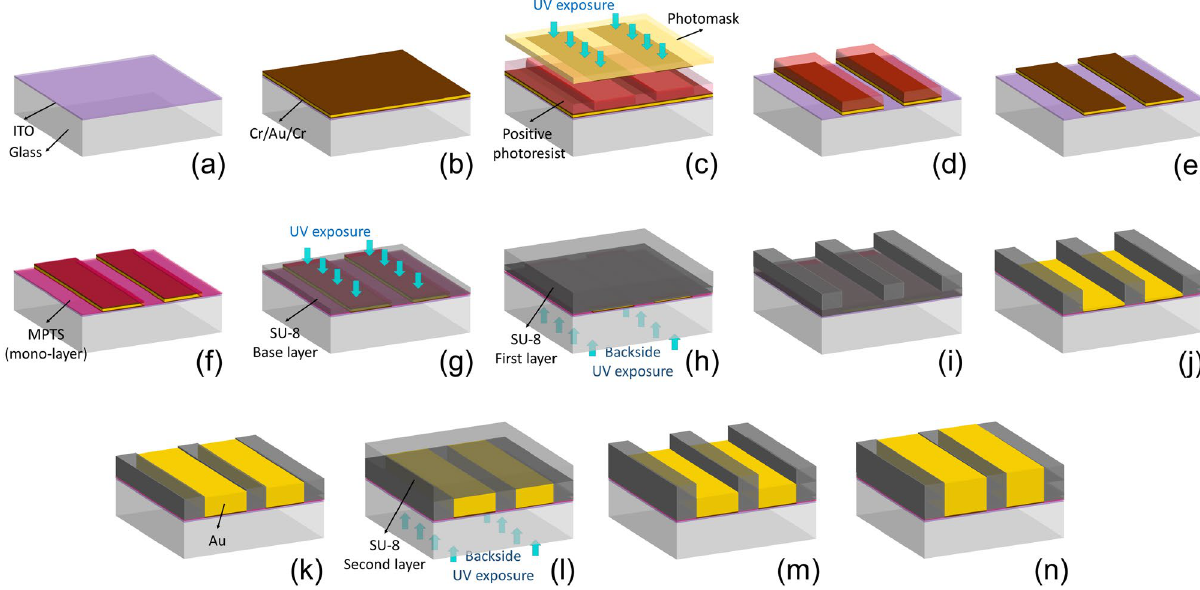
Figure 1. Process flow for fabricating self-aligned multi-layer high aspect ratio gratings. This graph illustrates the fabrication steps for two layers, where repeating steps (l) to (n) results in a multi-layer structure: ( a ) cleaning the ITO-on-glass substrate, ( b ) thermal deposition of Cr/Au/Cr thin films, ( c ) spin coating a positive photoresist and patterning it through a photomask, ( d ) etching uncovered Cr/Au/Cr parts, ( e ) cleaning the sample and removing the photoresist,(f) definition of a mono-layer 3-(Trimethoxysilyl)propyl methacrylate (MPTS) film, ( g ) definition of the SU-8 base layer and performing a flood exposure from the top, ( h ) spin coating the first SU-8 layer and performing a backside exposure, ( i ) developing the uncrosslinked SU-8, ( j ) performing an RIE to remove base SU-8 layer and etching the top Cr film, ( k ) gold electroplating to fill the gaps, ( l ) spin coating